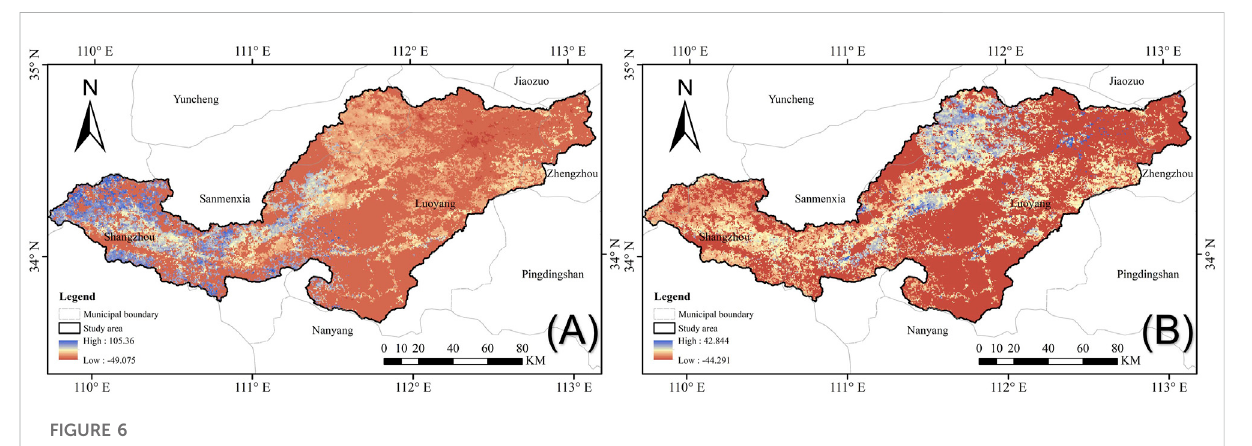
FIGURE 5 Distribution of NPP ’ s mutation points in the basin.